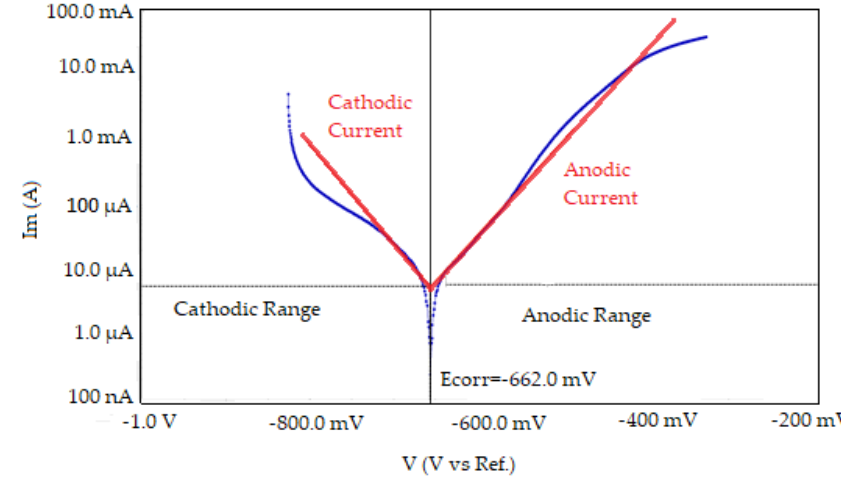
Figure 5. Tafel Plot from bare steel sample (Sample B).